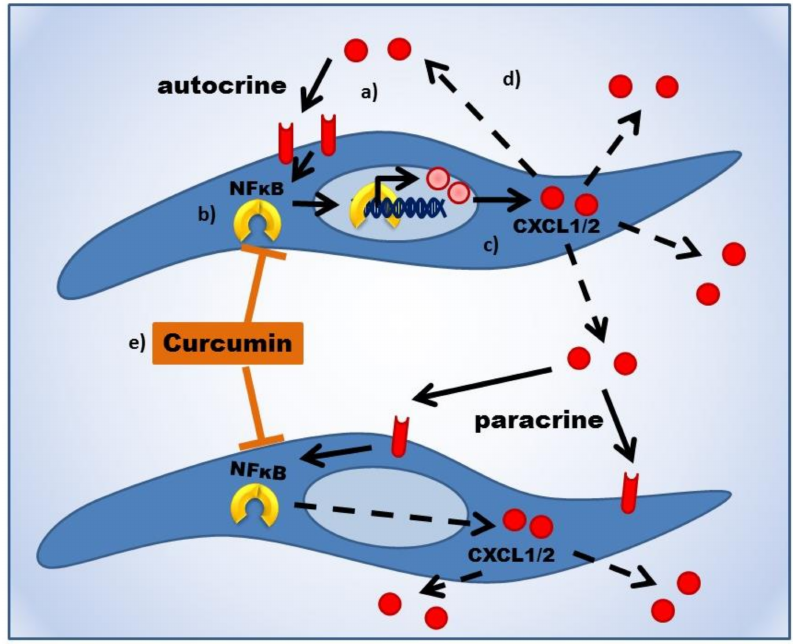
Figure 3. Feedback loop of CXCL-1 and 2 and NF κ B. The proinflammatory chemokines CXCL-1 and -2 activate NF κ B ( b ) by binding to their receptor CXCR-2 ( a ). In consequence, NF κ B translocates into